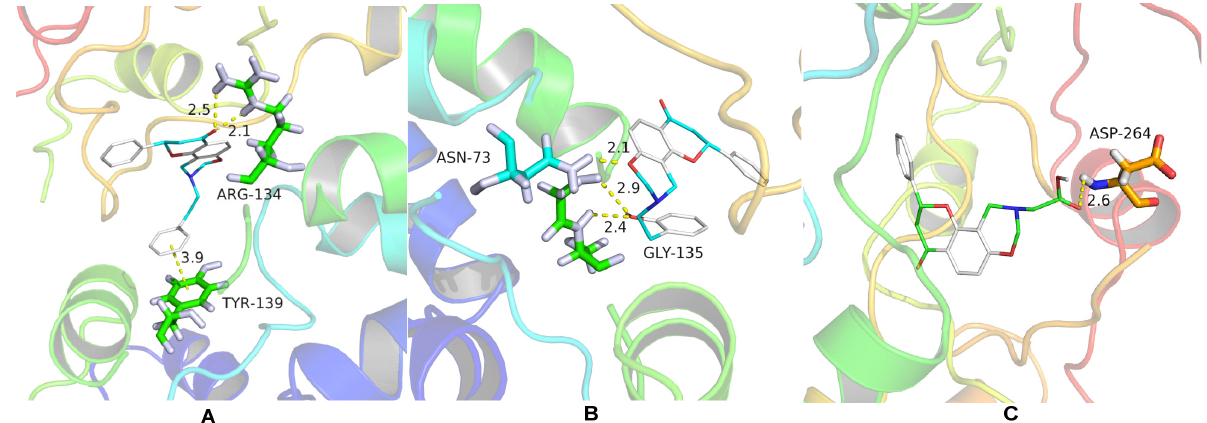
Figure 3. Molecule docking results of compounds 6n ( A ), 6p ( B ), and 6r ( C ) with TMV